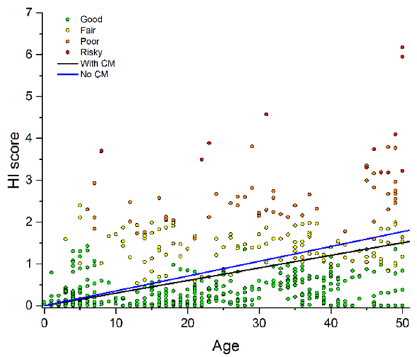
Figure 6. The results of the analysis for the power transformer population for two scenarios: actual aging (“no CM”) and with operational efforts to improve device health (“with CM”).